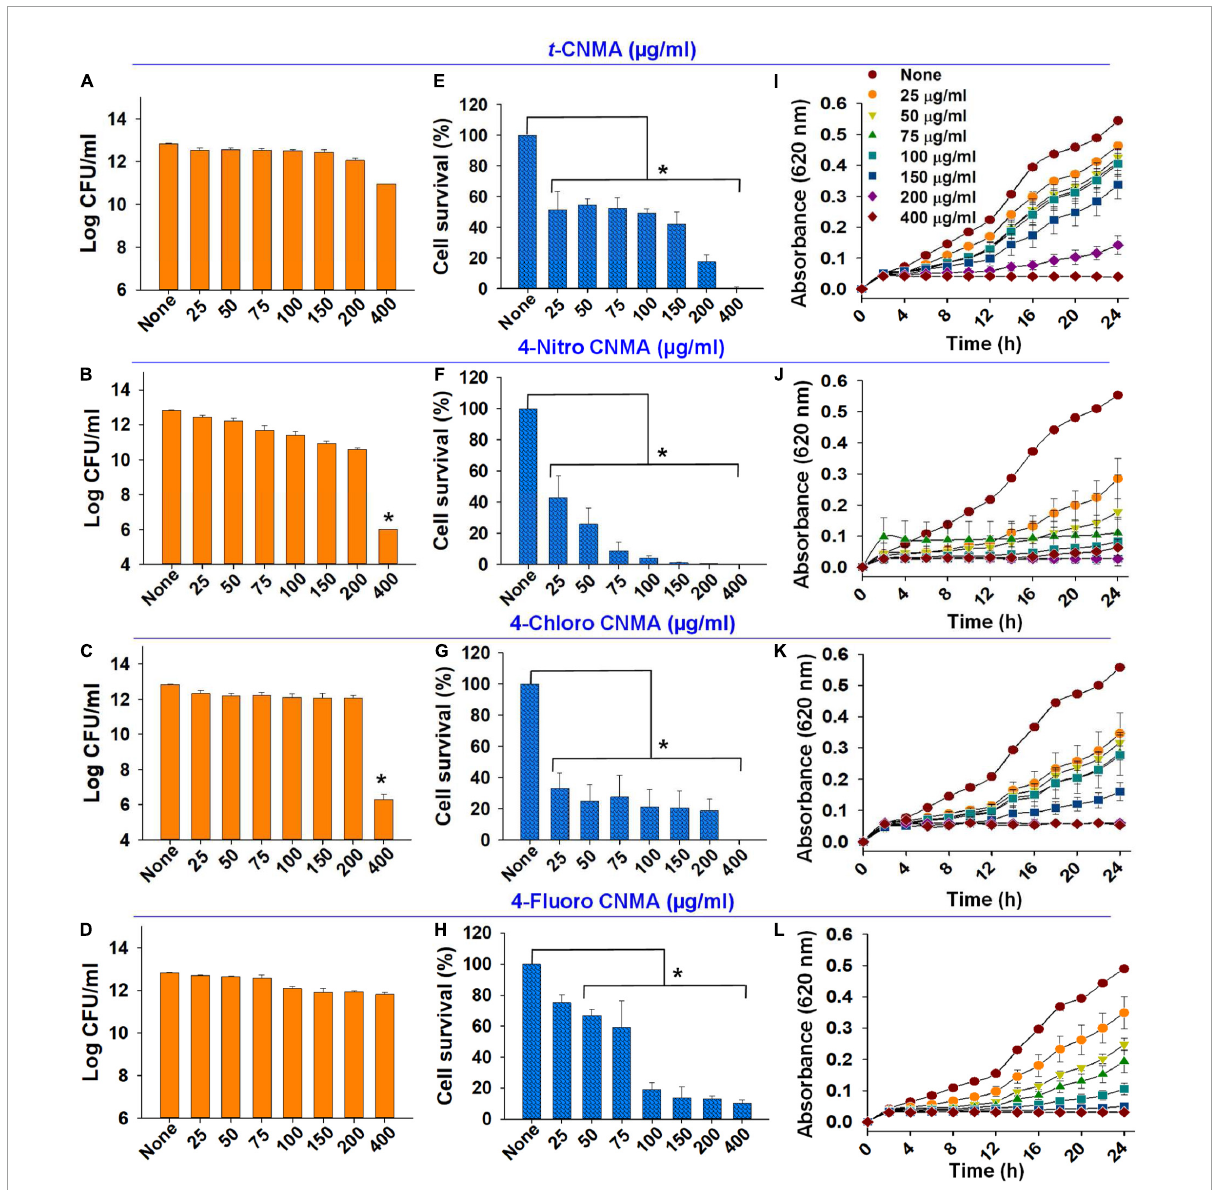
FIGURE6 Effects of cinnamaldehydes on A. tumefaciens planktonic growth. Log reduction in CFU counts by t -CNMA (A) , 4-nitro CNMA (B) , 4-chloro CNMA (C) , and 4-fluoro CNMA (D) ; percent cell survival after treatment with t -CNMA (E) , 4-nitro CNMA (F) , 4-chloro CNMA (G) , or 4-fluoro CNMA (H) for 24 h. Time and concentration-dependent growth inhibition were recorded every 2 h (I–L) . “*” denotes a significant difference in planktonic growth by the two-tailed t -test ( P ≤